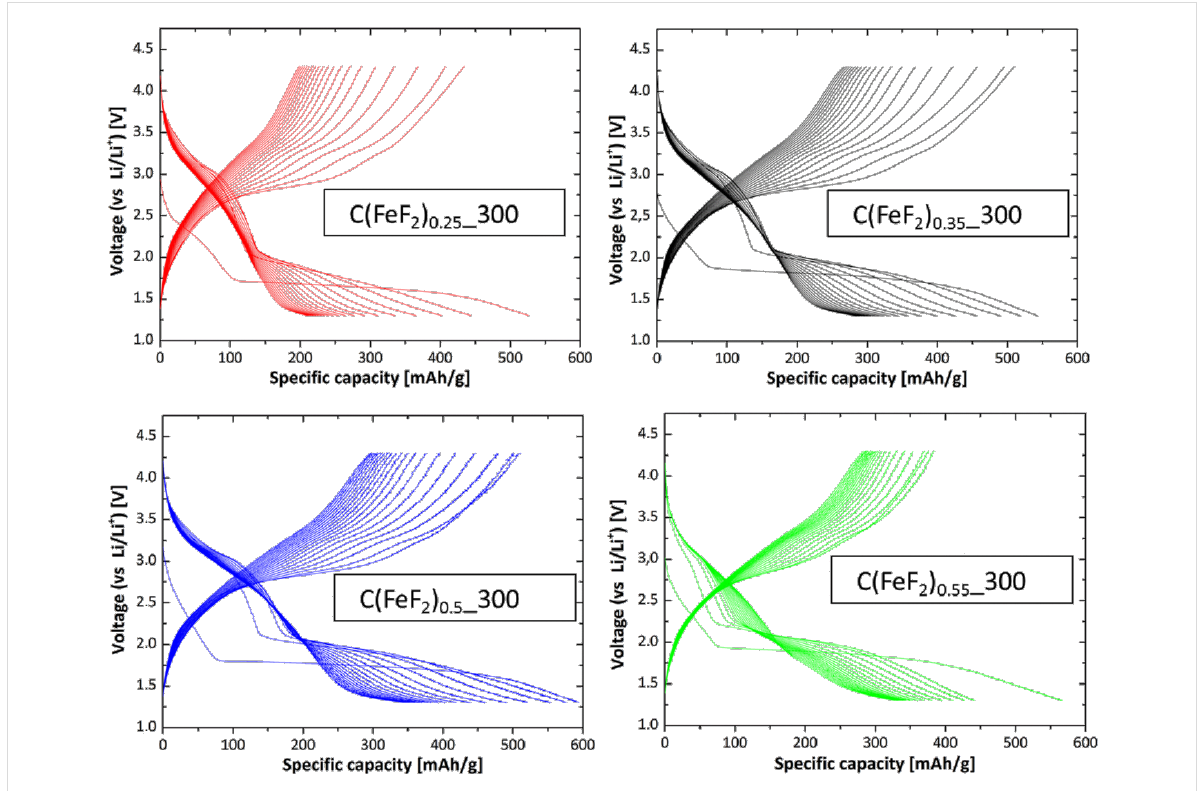
Figure 8: Charge/discharge profiles for the first 20 cycles of the nanocomposites at 25 °C. The samples were cycled with a current density of 25 mA/g.